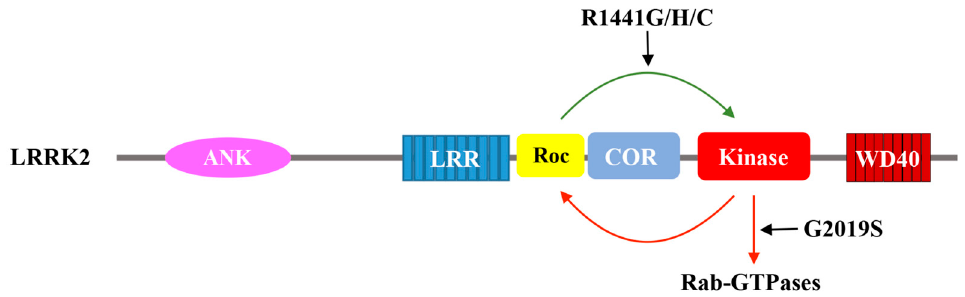
Figure 3. Schematic depiction of the catalytic activity of LRRK2. GTP binding to Roc activates the kinase domain, which in turn phosphorylates downstream substrates and potentially feedback to the Roc domain via phosphorylation. The Parkinson’s disease-associated mutation G2019S aberrantly over-activate the kinase domain. A set of Parkinson’s disease-associated mutations in the Roc domain (R1441G/H/C) also activate LRRK2 kinase activity.